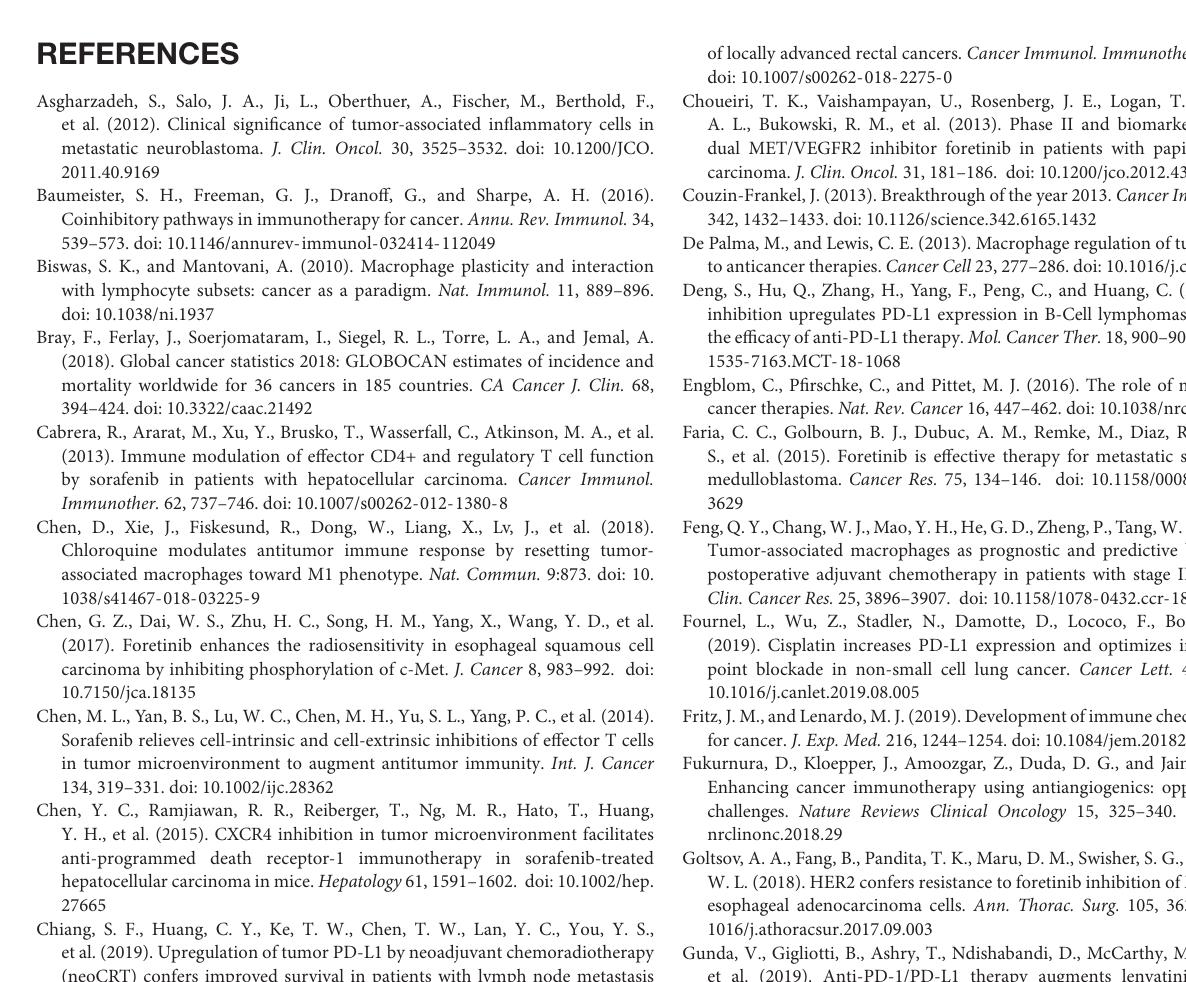
Supplementary Figure 7 | Foretinib enhanced the expression of PD-L1 in CT26 tumor. The level of proteins were detected by Western-blot in CT26 tumor tissue after treatment (left) and the relative protein expression was shown in (right), respectively ( n = 3 mice per group). The data is presented using the mean ± SEM where applicable, ∗ ( P ≤ 0.05), ∗∗ ( P ≤ 0.01), ∗∗∗ ( P < 0.001), ∗∗∗∗ ( P < 0.0001), and ns (no statistical significance, P ≥ 0.05). Supplementary Figure 8 | Combination therapy regulated Peripheral immune microenvironment. After the administration completed, the percentages of CD3 + , CD4 + , and CD8 + T cells, MDSCs, TAMs and Tregs in the peripheral blood and spleen in MC38 tumor model (A,B) and CT26 tumor model (C,D) were detected by flow cytometry, respectively ( n = 6 mice per group). The data is presented using the mean ± SEM where applicable, ∗ ( P ≤ 0.05), ∗∗ ( P ≤ 0.01), ∗∗∗ ( P < 0.001), ∗∗∗∗ ( P < 0.0001), and ns (no statistical significance, P ≥ 0.05). Supplementary Figure 9 | Foretinib inhibited tumor cells invasion and metastasis. The invasion and metastasis of colon cancer cells was detected by Transwell assay after treatment by different concentration Foretinib. Briefly, cells were added into Transwell chamber that already covered matrix glue. Then, added the final concentration were 0.01% DMSO and 1, 2, and 4 µ M Foretinib, and added 500 µ L RPIM-1640 medium containing 5% FBS to the 24 well plate. Then place the chamber into the plate and cultivated for 24 h. Fixing by methanol, staining by crystal violet and washing two times by dd H 2 O, and taking picture on microscope after drying the chamber. Scale bar, 50 µ